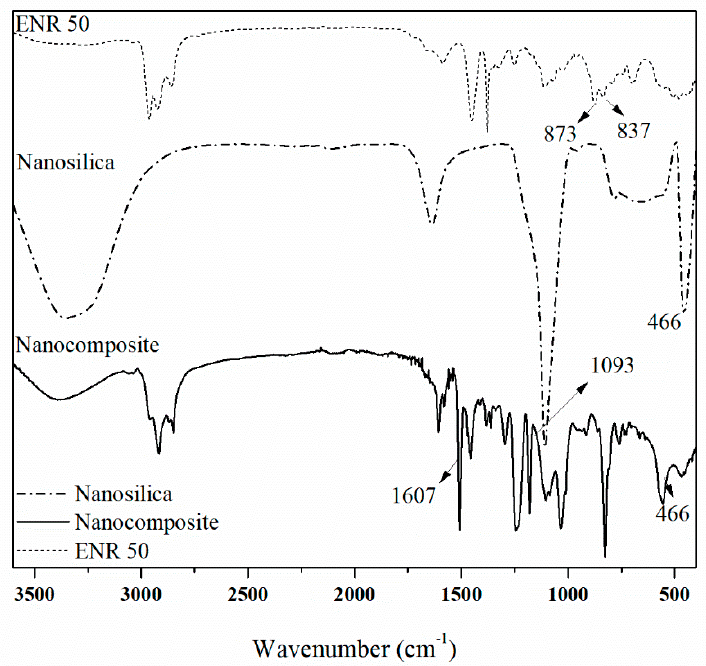
Figure 1. Fourier-Transform Infrared (FTIR) spectra of nanocomposite samples.